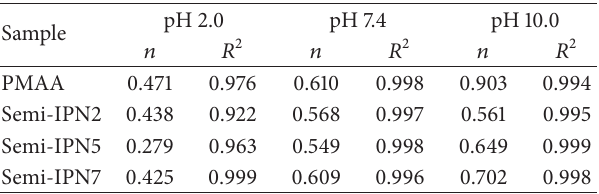
Table 2: Kinetic parameters of the PMAA hydrogel and xylan/PMAA semi-IPN hydrogels in buffer solutions of pH 2.0, 7.4, and